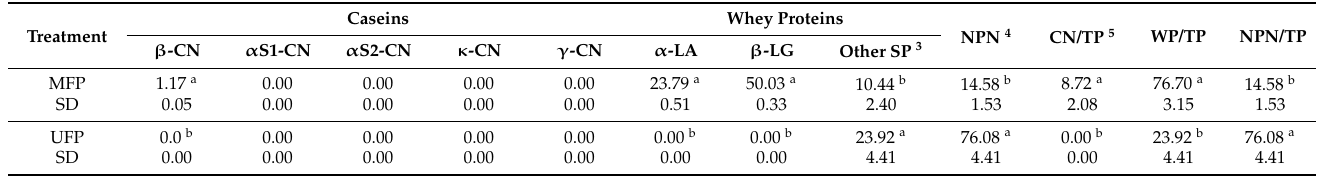
Table 8. Mean ( n = 3) protein fractions observed in capillary gel electrophoresis of permeate (MFP 1 and UFP 2 ) produced during microfiltration and ultrafiltration of skim milk using polymeric spiral-wound membranes.